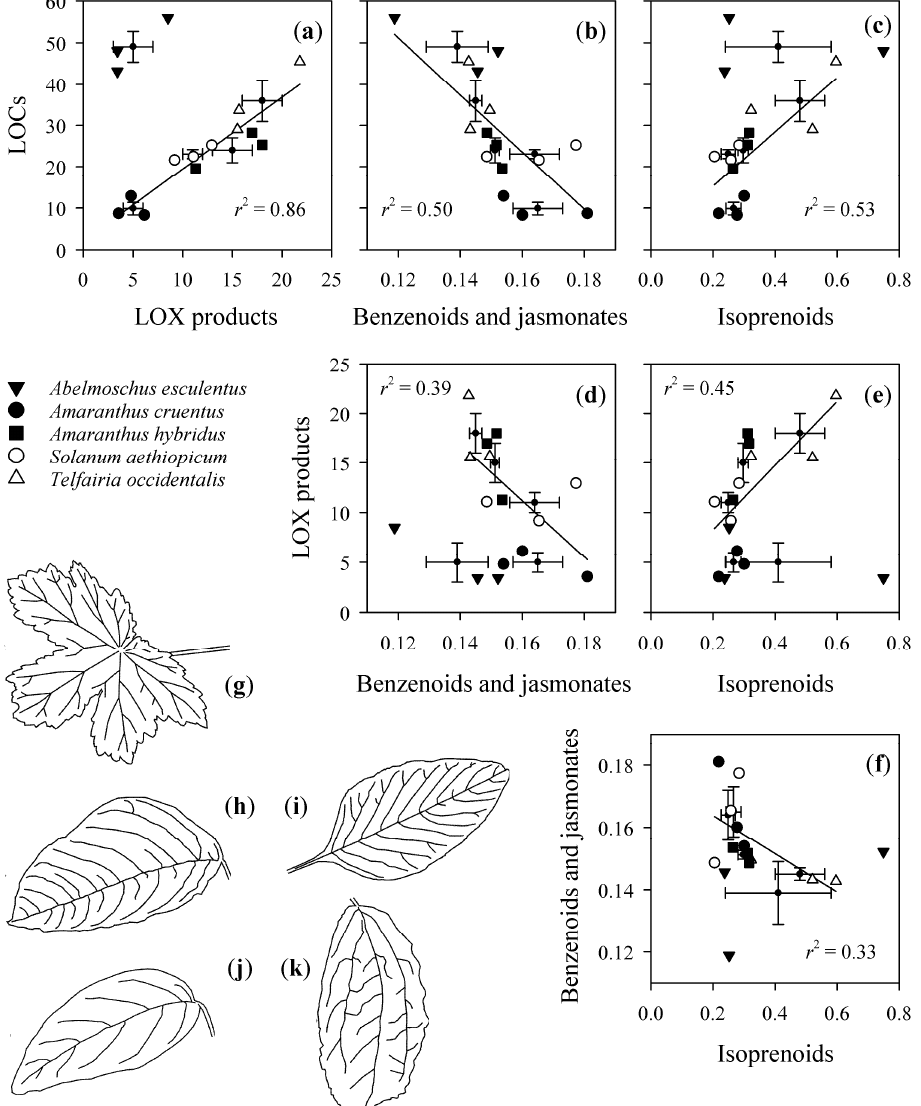
Figure 2. Correlations among ( a – f ) different classes of volatile organic compounds (VOCs) emitted [pmol mm − 1 ] upon leaf wounding from leaves of five tropical crop species. Panels ( g – k ) show the outlines of leaves of studied species: ( g ) Abelmoschus esculentus , ( h ) Amaranthus cruentus, ( i ) Amaranthus hybridus , ( j ) Telfairia occidentalis , and ( k ) Solanum aethiopicum . Different symbols were used for different species. Abelmoschus esculentus data were excluded in correlation with LOX products and isoprenoids. Filled points with standard error bars are averages for each species. Linear correlations shown are all significant at p = 0.05. LOX products stands for volatile products of lipoxygenase pathway (also called green-leaf volatiles, typically C 5 -C 6 aldehydes and alcohols, Table 1), and LOCs for low-weight oxygenated compounds (C 1 -C 3 volatiles synthesized through diverse pathways, Table 1). Isoprenoids identification by GC-MS can be found in Table S1, Supplementary Materials.